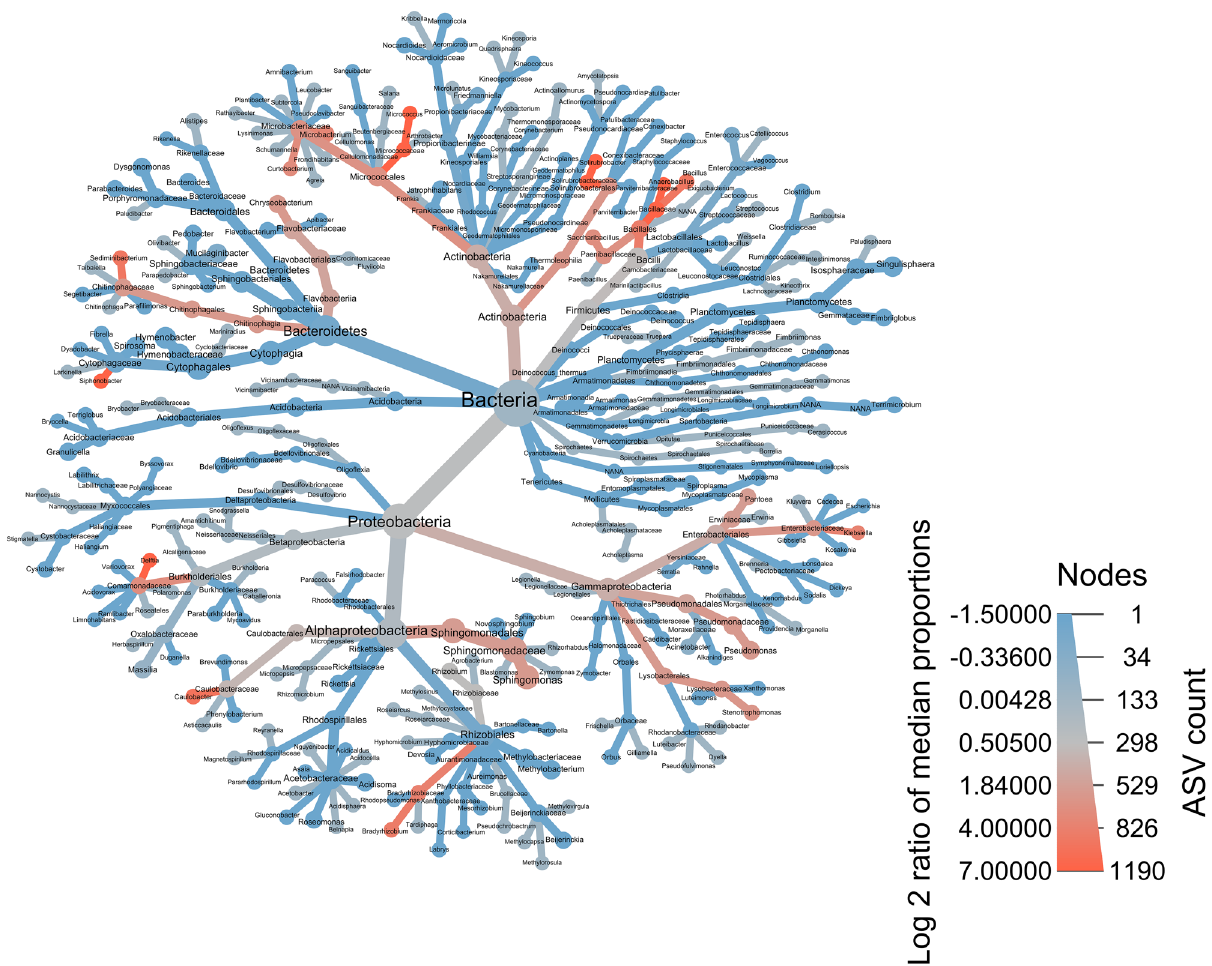
Figure 6. Taxonomic tree showing hierarchical structure of taxonomic ranks (denoted at each graph node) of 221 unique genera, and their membership in community assemblages based on the log 2 of median ratios of genera detected within throughfall (blue), rainwater (red) and taxa found in both throughfall and rainwater (gray) samples. Thickness of graph edges indicate relative abundance of taxa. This figure was produce using the ‘metacoder’ package (ver. 0.3.4; https ://grunw aldla b.githu b.io/metac oder_docum entat ion/index .html) 77 in program R (ver.